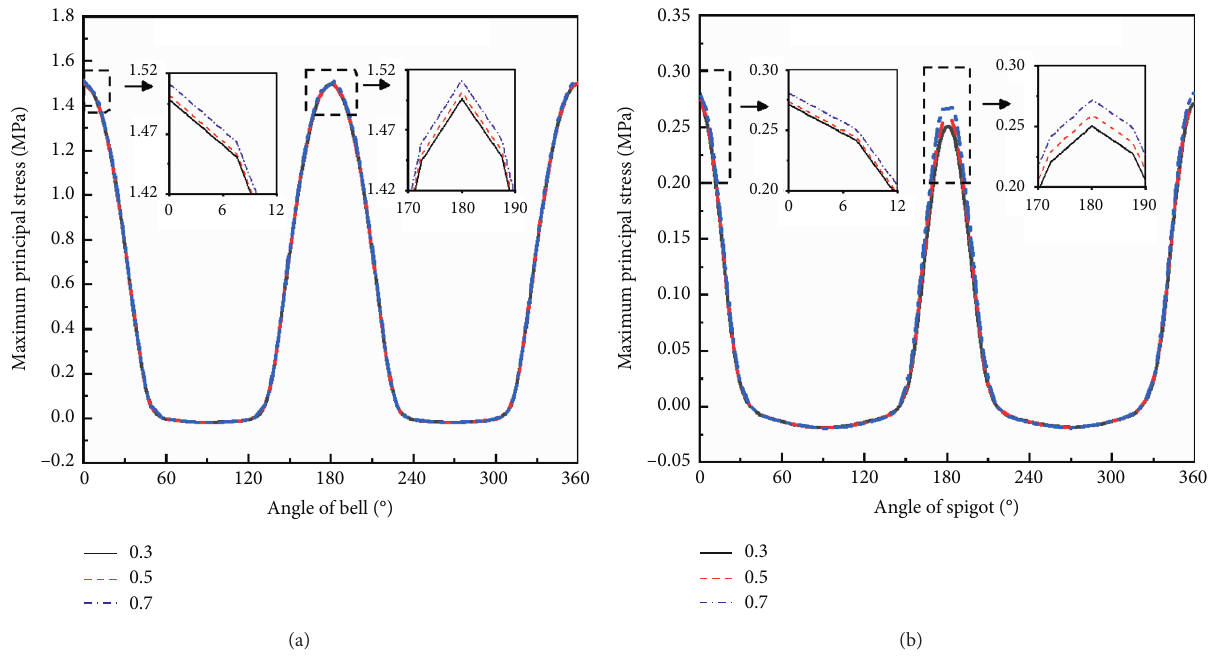
Figure 14: Maximum principal stress of (a) the bell and (b) the spigot under different flow.